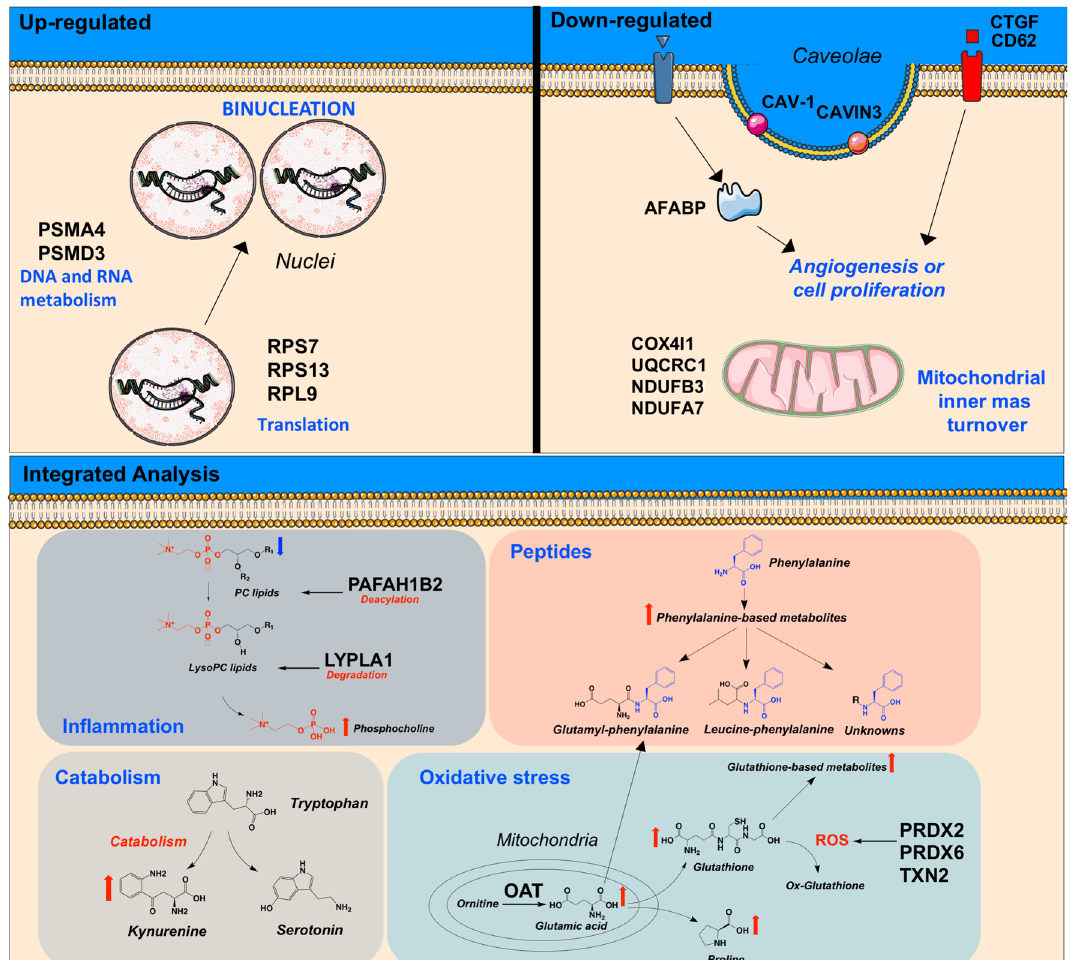
Figure 8. Summary illustration of study findings. Cellular structures were created using Servier Medical Art templates, which are licensed under a Creative Commons Attribution 3.0 Unported License; https:// smart. servi er. com. Chemical structures were drawn by ChemDraw Professional version